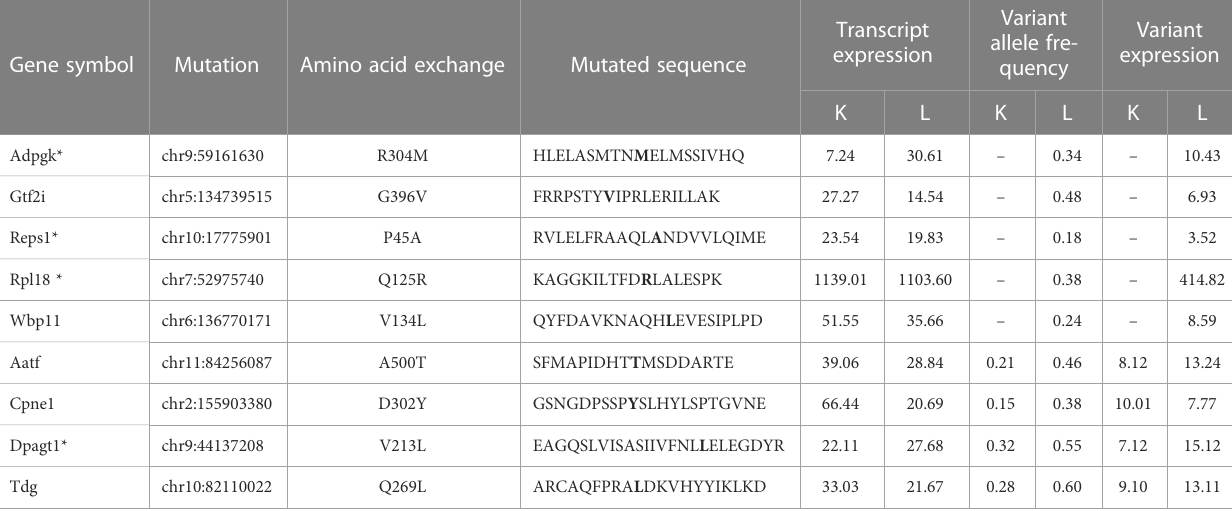
TABLE 1 Expression of previously published (candidate) neoantigens in the MC38-K and MC38-L cell